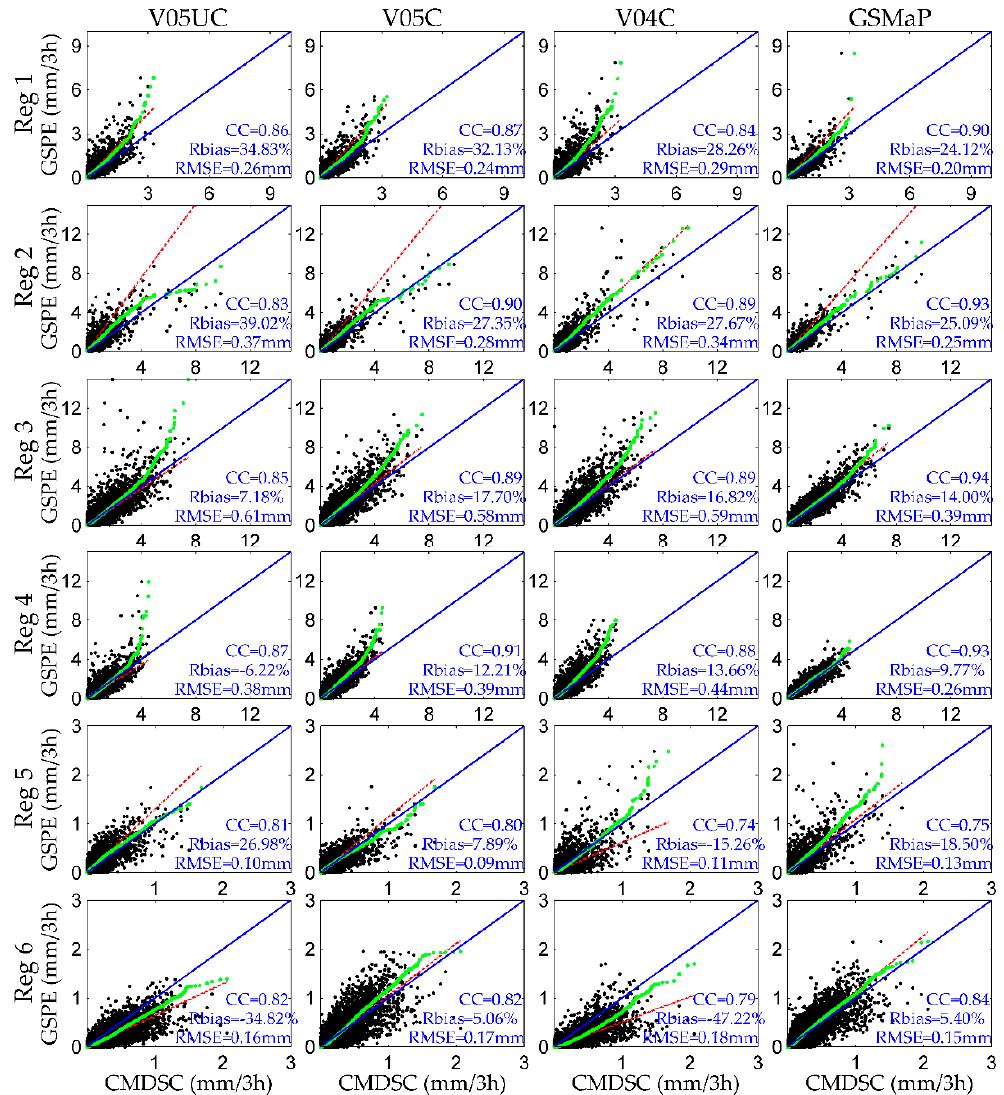
Figure 4. Quantile–Quantile (Q–Q) plots (green) and scatterplots (black) of 3-h scale regional averaged precipitation accumulation (mm/3 h) from GSPEs against the CMDSC over six regions during April 2014 and December 2016.